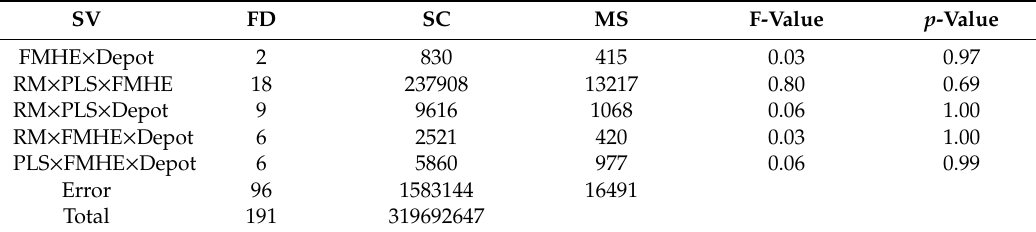
Table 5. Time savings (seconds) and percentage savings (%) of discrete PSO by FMHE.